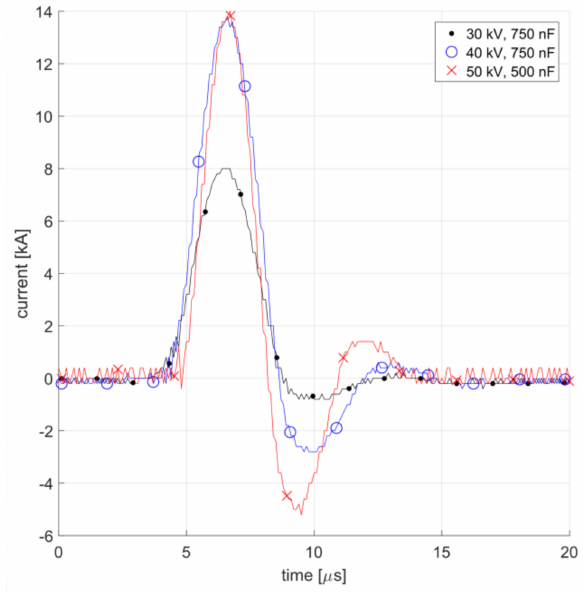
Figure 2. Discharge current of ImpulsTec installation from oscilloscope